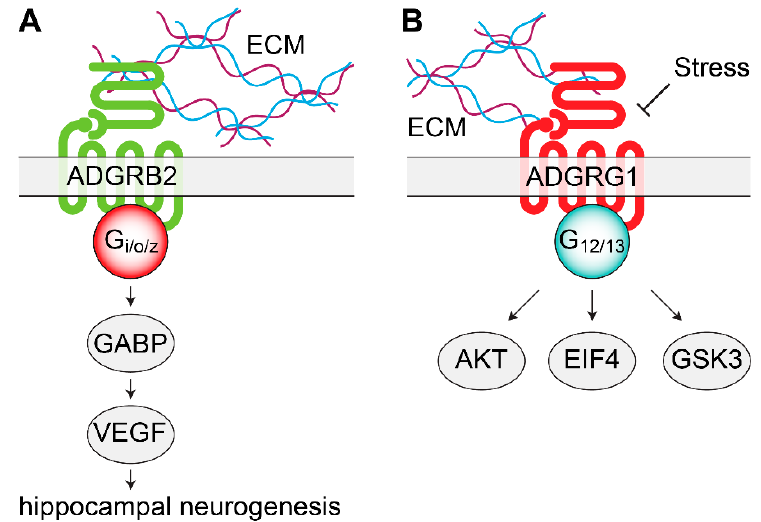
Figure 1. Signaling mechanisms of adhesion orphan G protein coupled receptors (oGPCRs) involved in mood disorders. ( A ) ADGRB2 interacts with the ECM to activate Gi/o/z proteins. In the dentate gyrus of the hippocampus, ADGRB2 activates intracellular GABP and VEGF, leading to increased neurogenesis. ( B ) Stress decreases ADGRG1 mRNA levels. By coupling with G12/13, ADGRG1 modulates AKT, GSK3, and EIF4 signaling pathways, intracellular signaling molecules previously associated with depression and with the action of antidepressants. AKT, protein kinase B; ECM, extracellular matrix; EIF4, eukaryotic initiation factor 4F; GABP, GA-binding protein; GSK3, glycogen synthase kinase 3; VEGF, vascular endothelial growth factor.